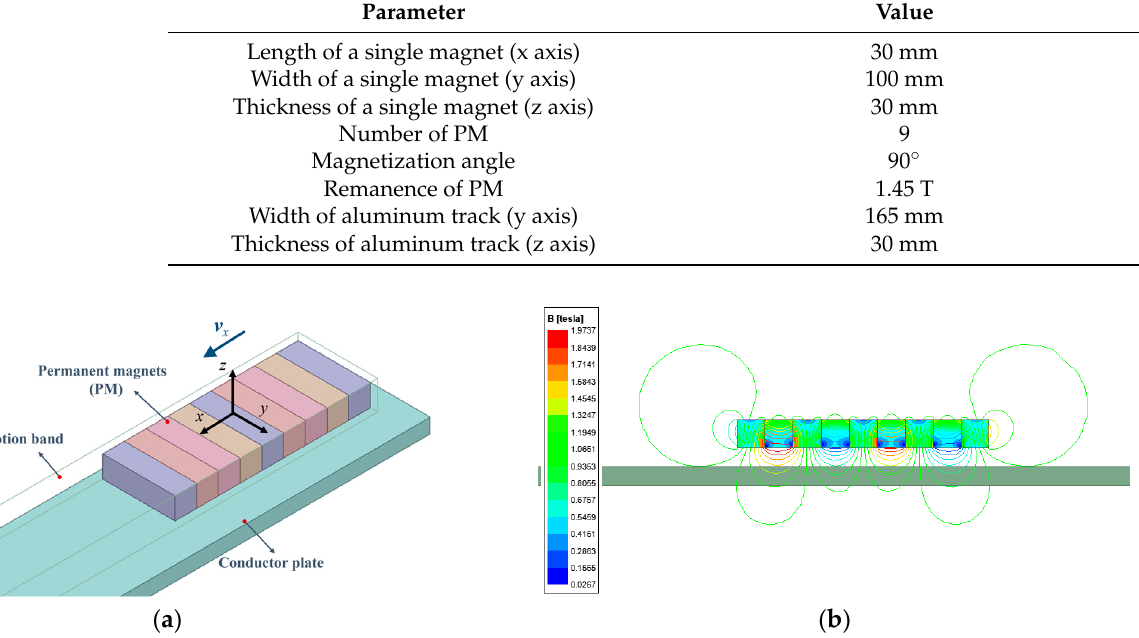
Table 1. Parameters of the PM EDS system. Figure 2. Guidance force analysis under different conditions: ( a ) PM and track are in alignment; ( b ) The vehicle exists in transverse displacement.